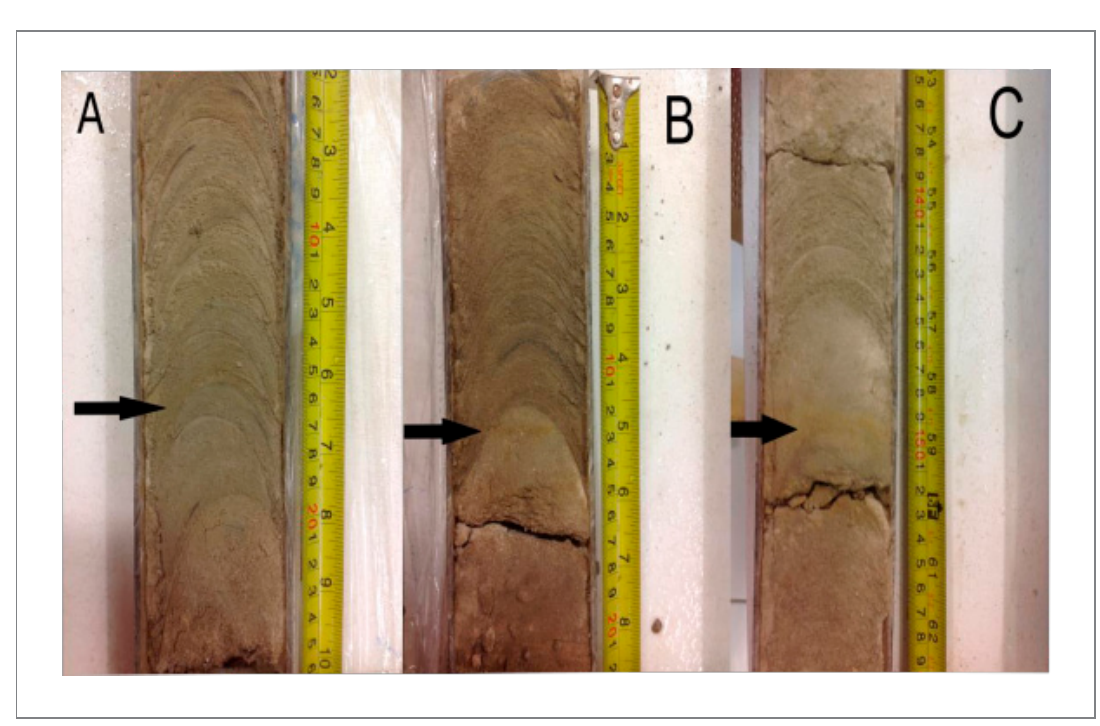
Figure 4 - (A) Light brown color 5YR 6/4 about 15 and 16 cm. SIS-515. (B) Light brown color 5YR 6/4 at 12 cm depth. SIS-454. (C) Light brown 5YR 6/4 about 149 cm depth.